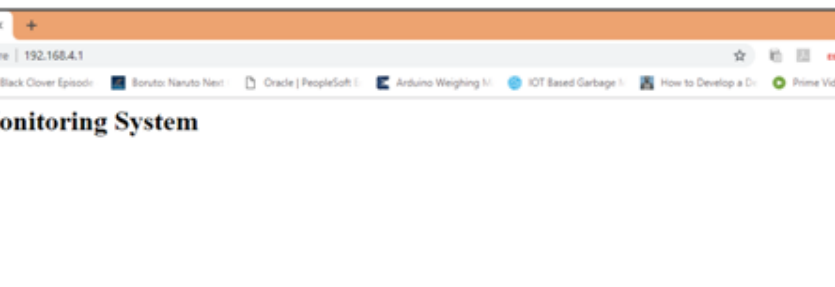
Figure 17. Monitoring system output (in this case, the bin is full, the output is complete).